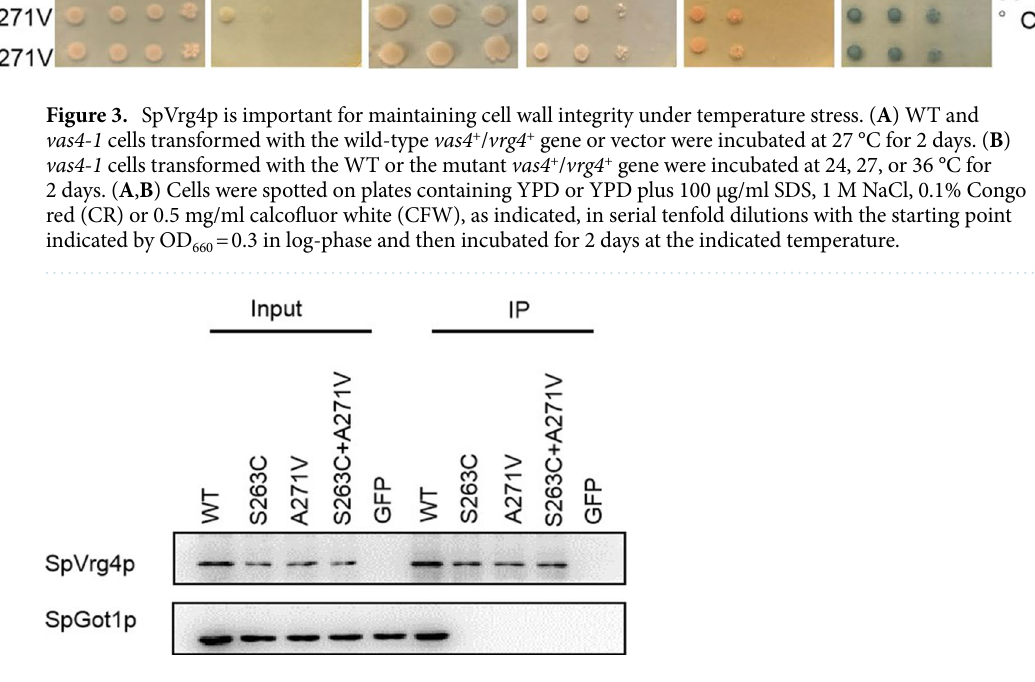
Figure 4. The mutations in SpVrg4p abrogated the interaction with Got1p. GFP and GFP-tagged Vrg4 were precipitated by GFP beads, washed extensively, subjected to SDS–PAGE and detected with anti-GFP or anti- Got1p